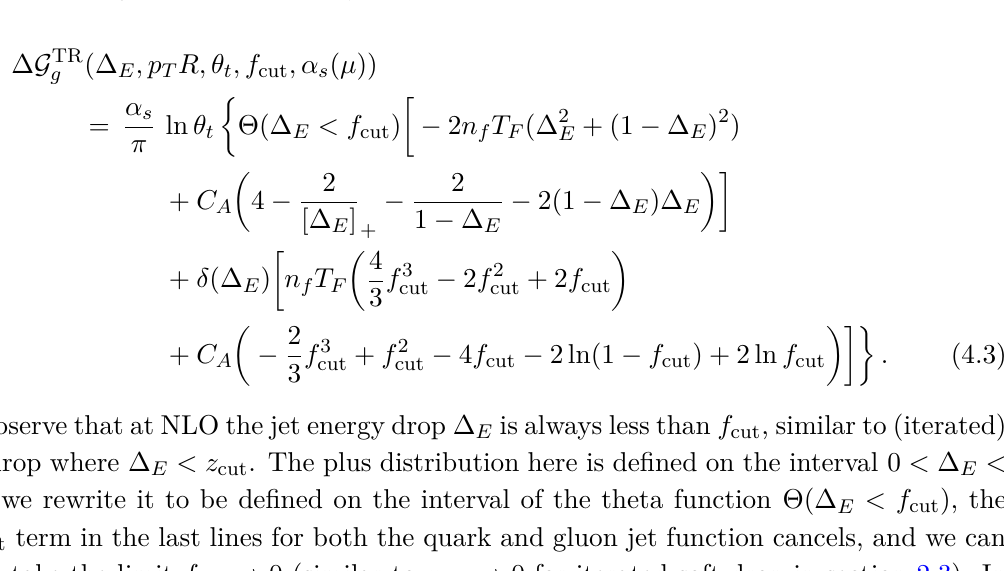
Figure 21 . Numerical comparison of the size of singular (dashed blue) and non-singular (dotted green) terms of the fixed-order (red) jet function for trimming. We show the quark and gluon result in the left and right panel,